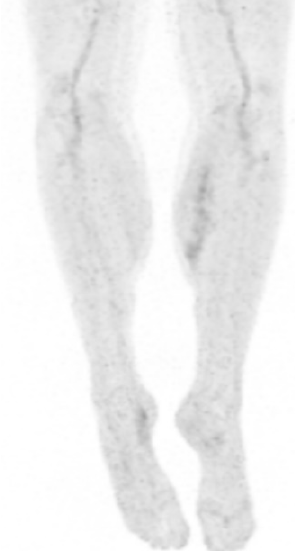
Figure 4. PET in February 2021 CR showing evidence of remission.